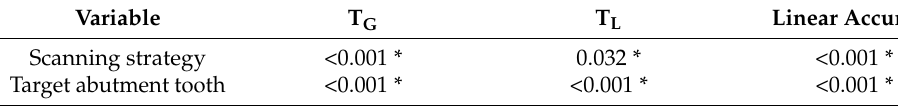
Table 1. p -values acquired by two-way ANOVA for T G , T L , and linear accuracy.